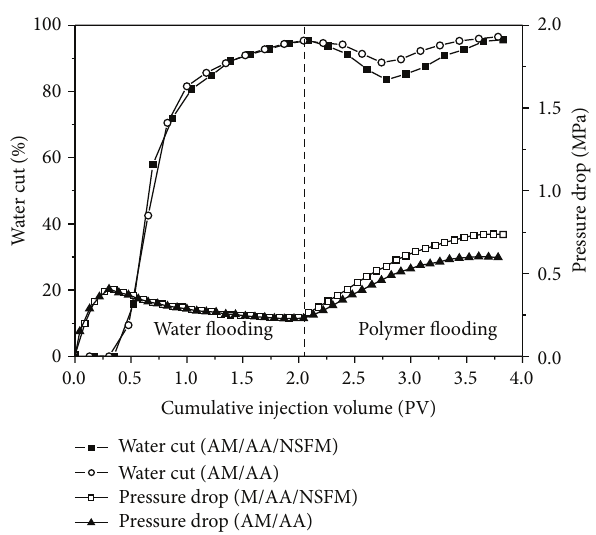
Figure 12: Core flooding experiments results of AM/AA/NSFM and AM/AA (0.2wt%) at 65 ∘